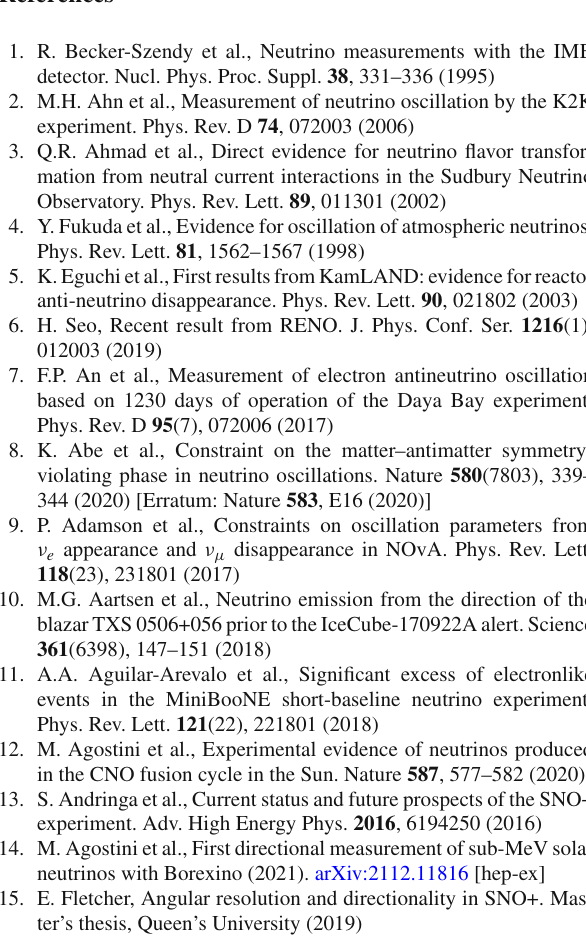
Table 4 The Cherenkov selection results for the WbLS mixtures. The cated otherwise in a credit line to the material. If material is not included in the article’s Creative Commons licence and your intended purities have been calculated using the MC truth information over the use is not permitted by statutory regulation or exceeds the permit- optimized window ted use, you will need to obtain permission directly from the copy- 1% 5% 10% right holder. To view a copy of this licence, visit http://creativecomm ons.org/licenses/by/4.0/. t f (ps) 300 200 200 Funded by SCOAP 3 P ( % ) 80.4 68.6 64.3 χ 2 / ndf 298.1/235 561.7/457 698.8/505